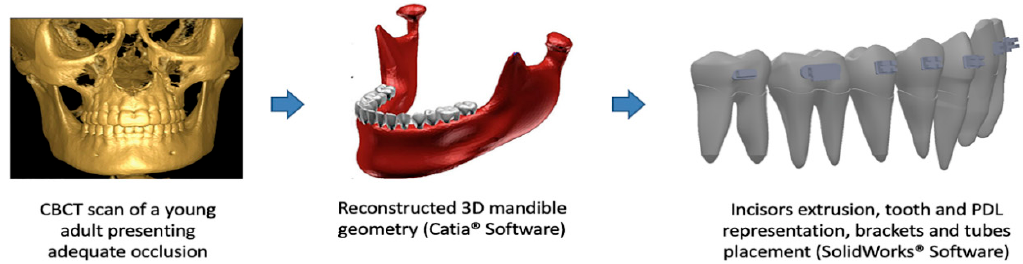
Figure 1. Sequence for three-dimensional (3D) model construction and finite element (FE) representation of tooth, periodontal ligaments PDL, and bone.